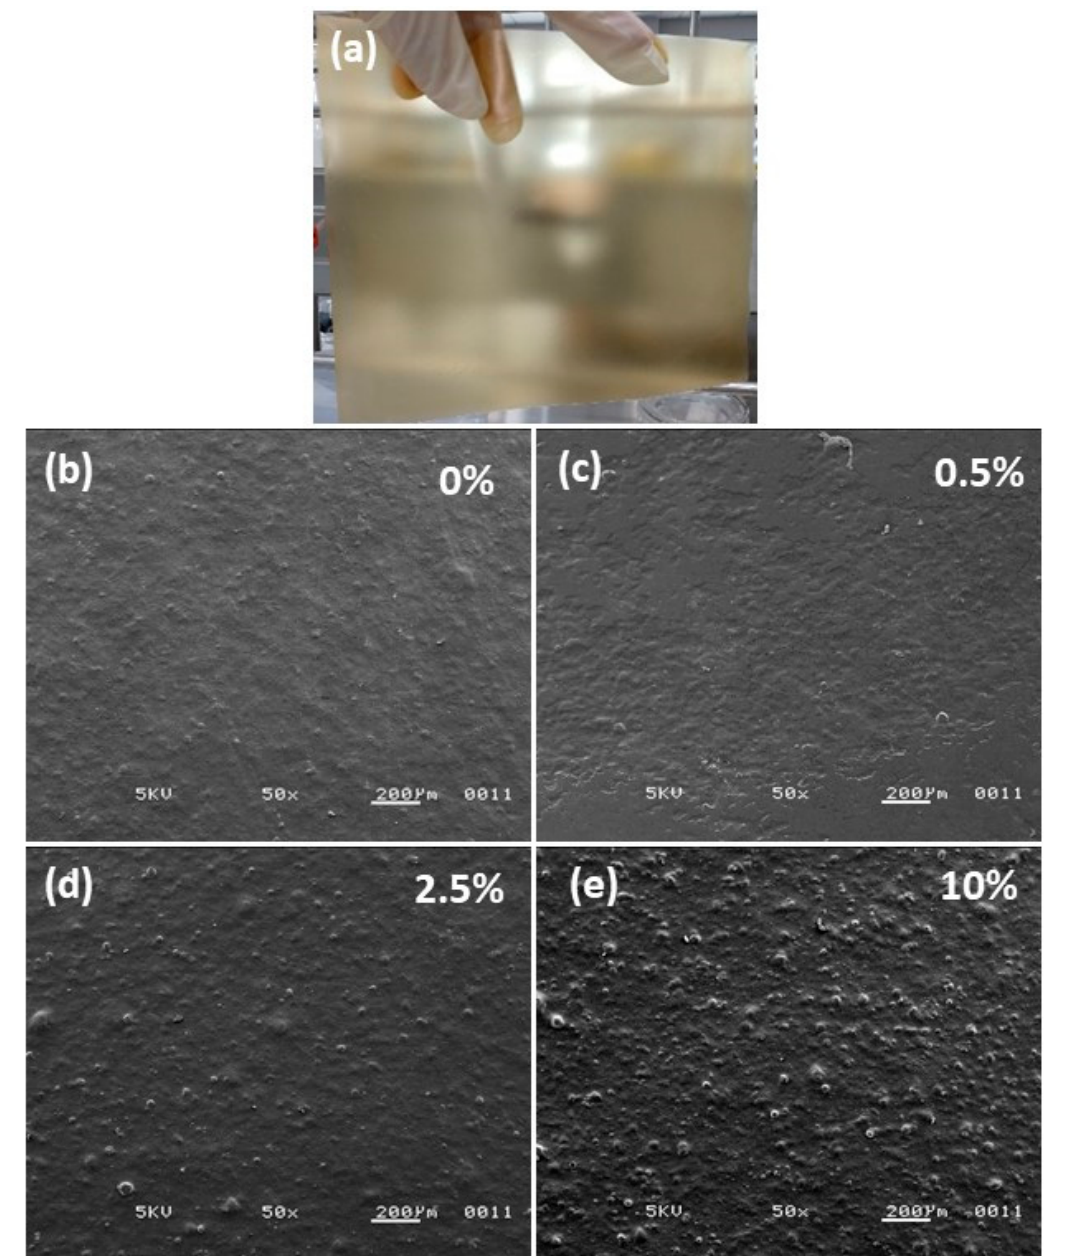
Figure 2. ( a ) Photograph and top surface morphology of corn starch–chitosan films with cellulose nanocrystals (CNC) at ( b ) 0%, ( c ) 0.5%, ( d ) 2.5%, and ( e ) 10% ( w / w ).